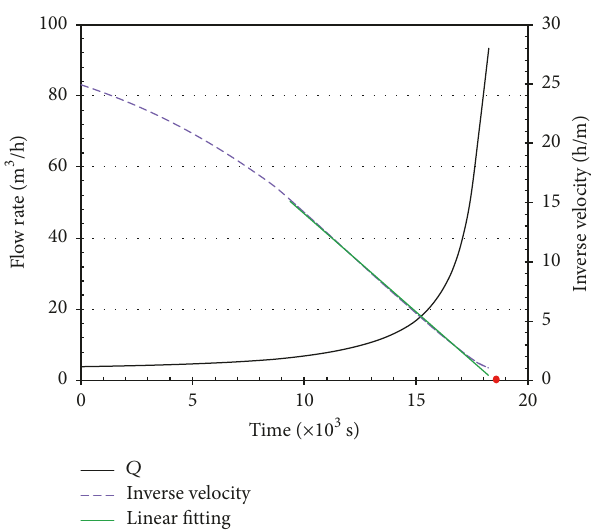
Figure 19: Water flow rate along the bottom surface of the numerical model.